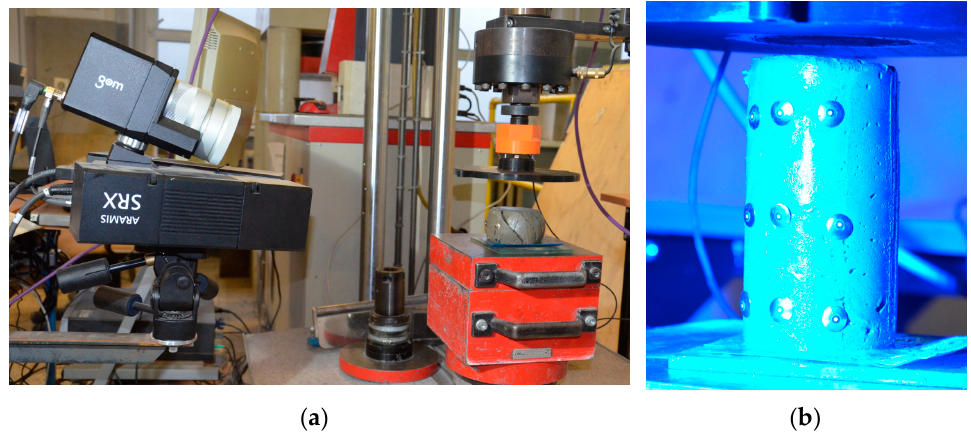
Figure 7. View on the test stand ( a ) ARAMIS system and sample after failure ( b ) sample at the beginning of the test.